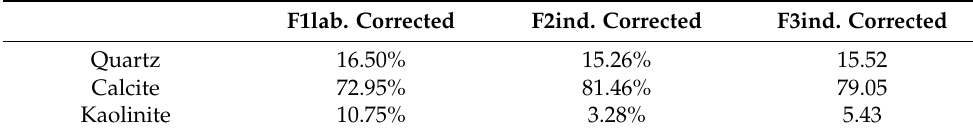
F1lab. Corrected F2ind.